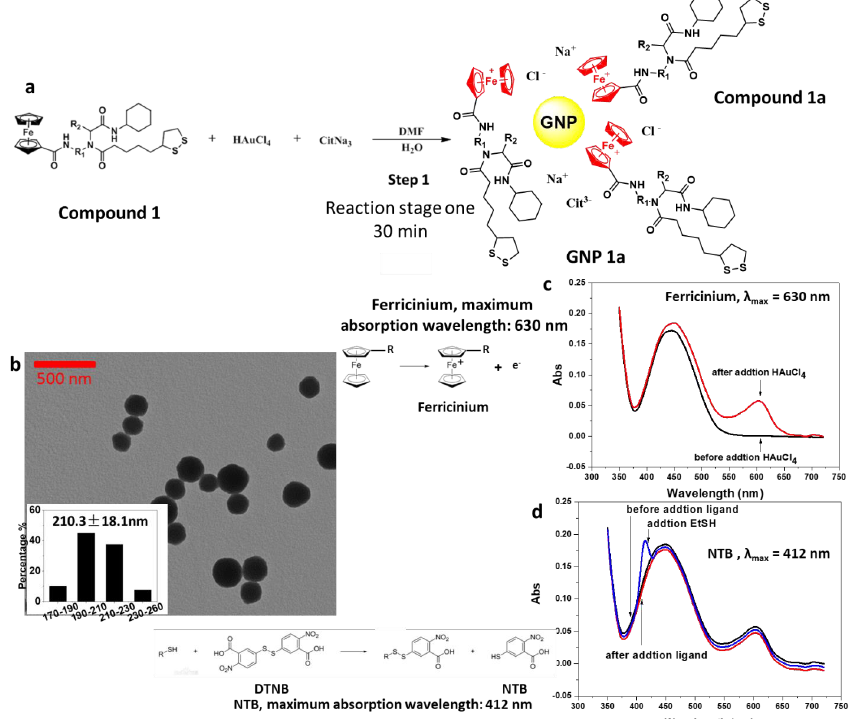
Figure 1. Reaction of ferrocene derivatives with HAuCl 4 in stage one. ( a ) Reaction scheme. Au(III) obtains electrons and was reduced to Au(0) to form the initial gold nucleus. At the same time, the ferrocene structure in the ligand lost electrons and transformed into ferricinium ( Compound 1a ). ( b ) UV–Vis spectrum of the supernatant (λ max = 630 nm) showed that ferricinium intermediates appeared during the reaction. ( c ) TEM images of the GNPs core showed GNPs core with diameters about 200 nm approximately (mid product). ( d ) UV–Vis spectrum of the supernatant (λ max = 412 nm). No sulfhydryl groups appeared during the reaction of chloroauric acid with ferrocene.